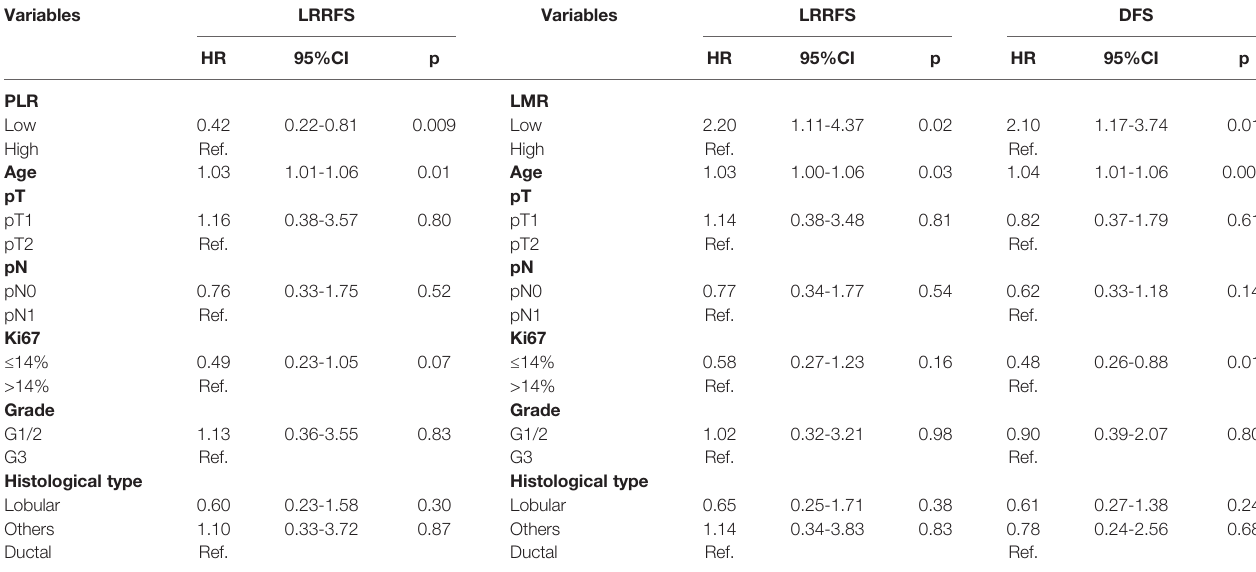
TABLE 4 | Multivariate analysis of in fl ammatory and clinical characteristics in relation to 5-years LRRFS, DFS in ER+ HER2- early breast cancers not treated with chemotherapy (n=999).